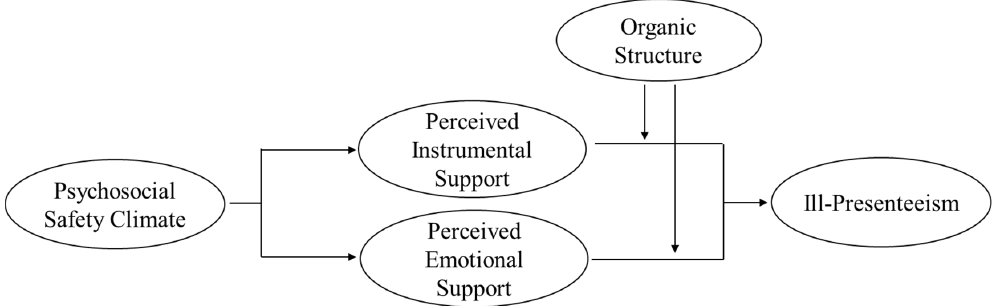
Figure 1. Theoretical model.